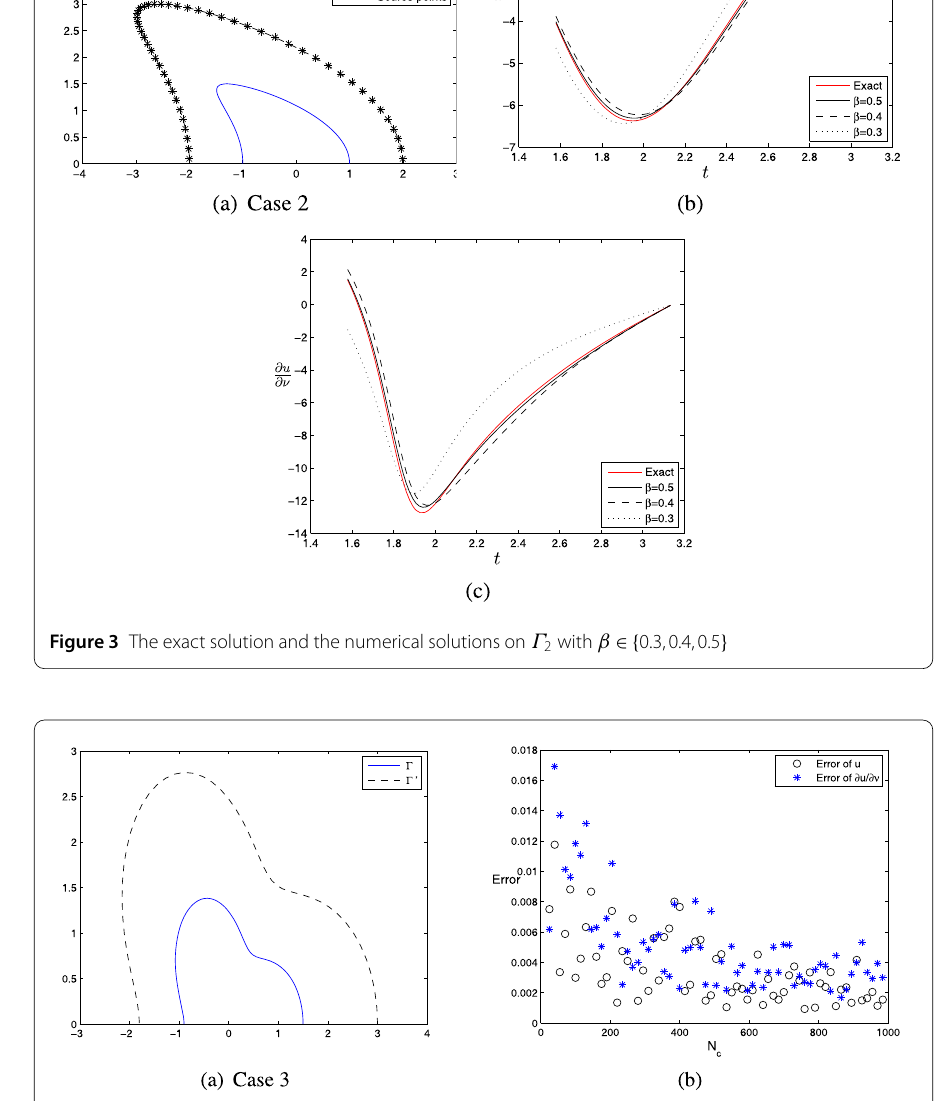
Figure 5 shows the numerical solutions with different noise levels δ = 0.01, δ = 0.03, and δ = 0.05. As is shown in Fig. 5, the computation of ∂ u